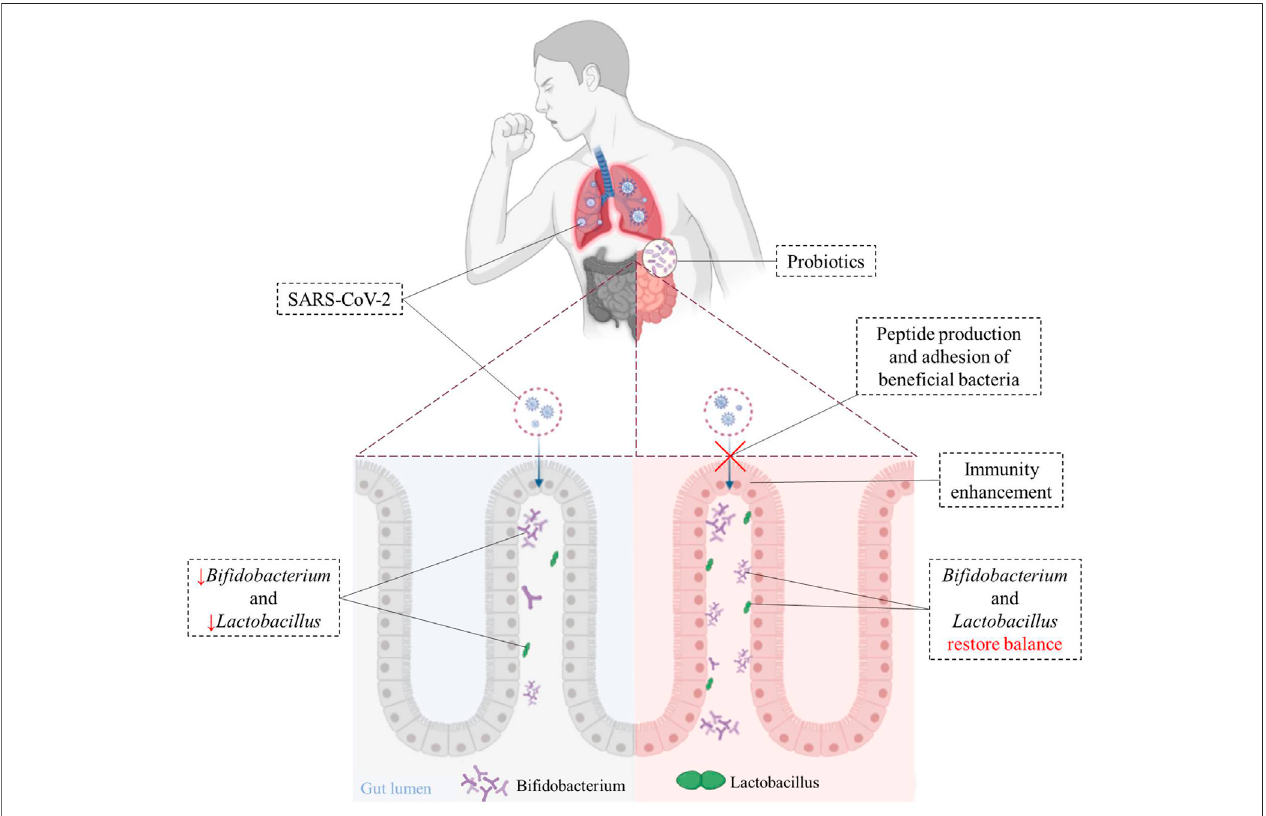
FIGURE 2 | Immunoregulatory effects of probiotics on cells after SARS-CoV-2 infection. Bene fi cial bacteria from oral probiotics can block the binding of SARS-CoV-2 to the host cells, and helps improve gut dysbiosis caused by SARS-CoV-2 and hastens recovery in patients. The use of probiotics can suppress in fl ammatory-cytokines and help clear viral